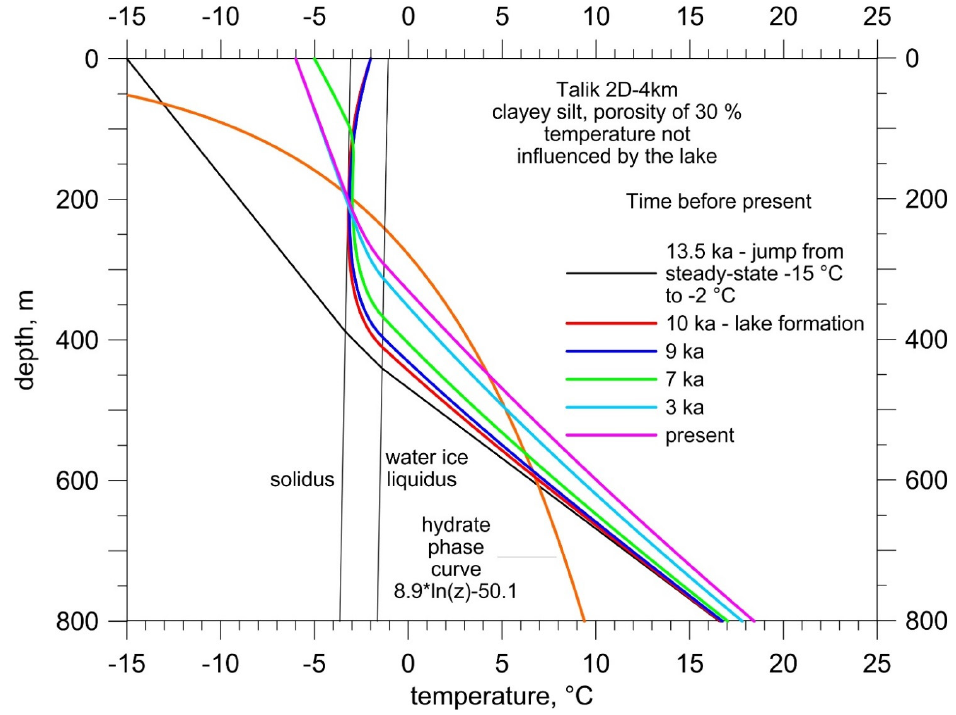
Figure 10. Illustration of the effect of position relative to the lake center for the 30% porosity clayey silt model with a 4 °C lake bottom temperature. The upper panel is the center of the lake with fully developed talik and out of GH stability zone. The middle panel is the lake’s margin with permafrost temperature at or above the solidus–liquidus mean and marginal GH stability conditions. The lower panel is for the area beyond the margin of the lake where the lake does not influence the position of pre-existing permafrost and GH stability